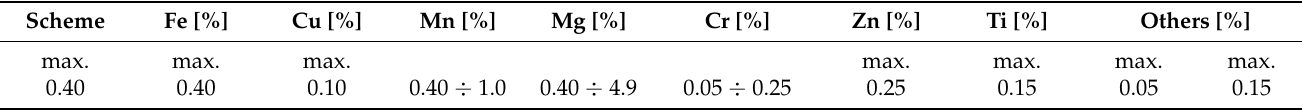
Table 1. Chemical composition according to EN573-3.